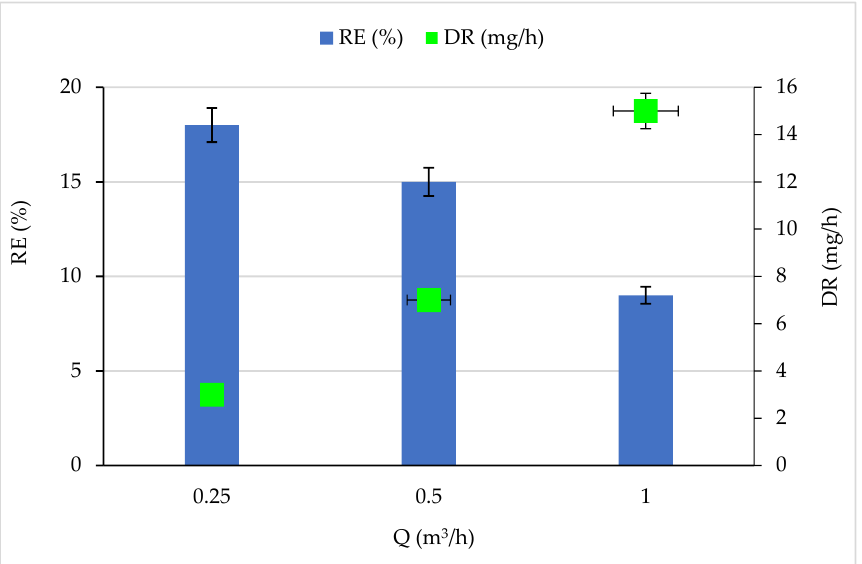
Figure 2. Effect of feed flow rate on CB removal efficiency and degradation rate. Experimental conditions: RH: 5%, T: 20 ◦ C and C: 13 mg/m 3